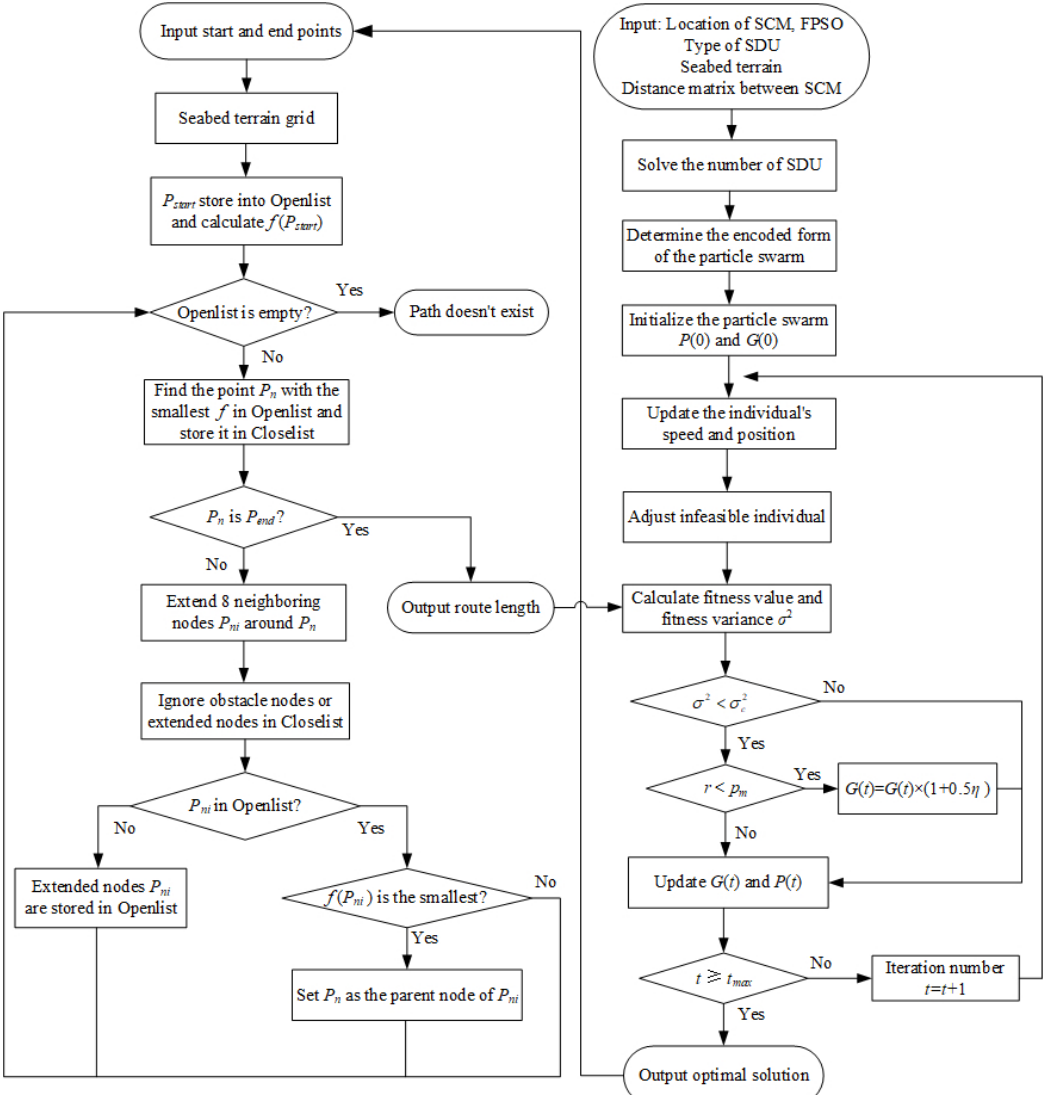
Figure 4. The hybrid algorithm flow diagram of the integral